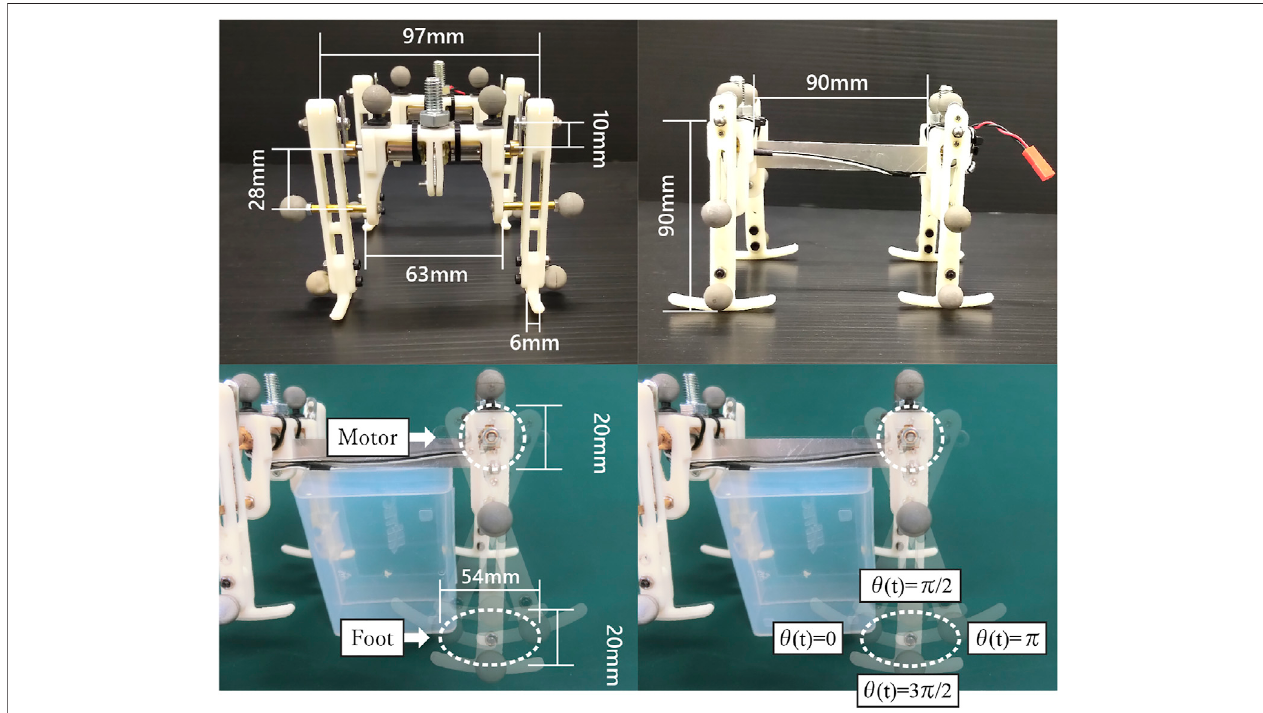
FIGURE 3 | Measurements of the robot. We designed the distance between the crank tip and foot tip to be 90 mm, and the foot width is 6 mm. The right fi gure shows the foot trajectory of the robot. The blue box in the center of the image is a stand for fi xing the robot in the air.